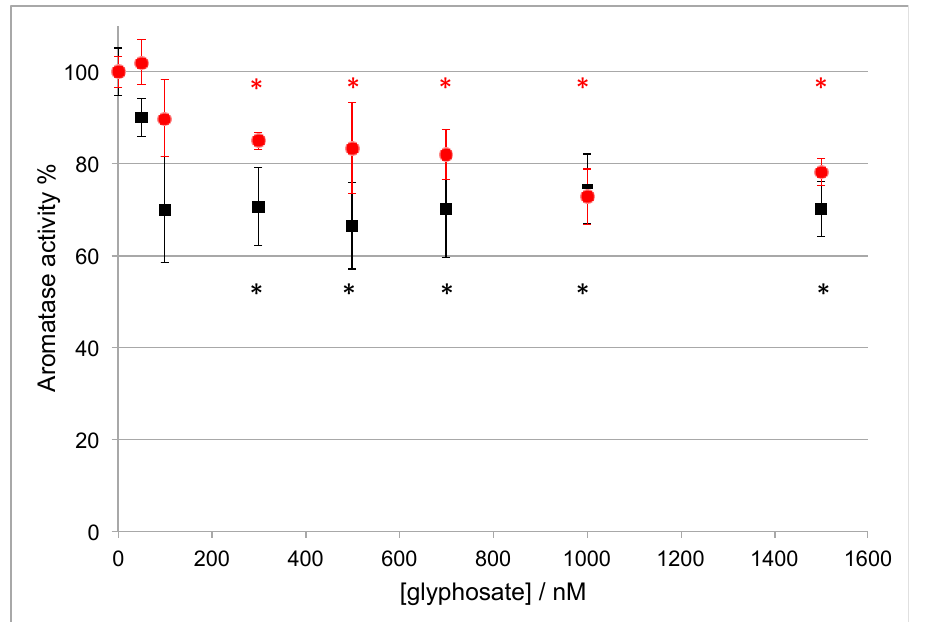
Figure 1. Aromatase activity in the presence of different concentrations of glyphosate and 50 nM (black squares) or 400 nM (red circles) of the substrate androstenedione. Statistical significance *: p -value < 0.05 versus C + .